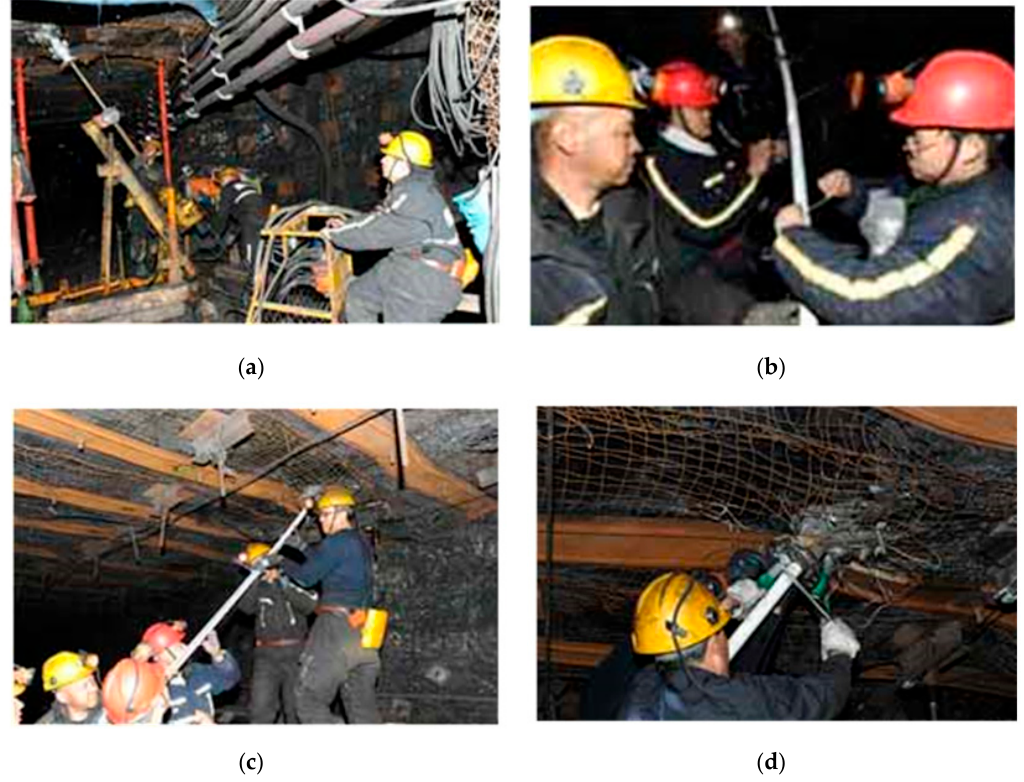
Figure 19. Process of embedding optical fiber in roof rock. ( a ) Drilling a borehole. ( b ) Fiber binding to the outer wall of PVC pipe. ( c ) Laying fiber through PVC pipe. ( d ) Grouting and sealing in borehole.